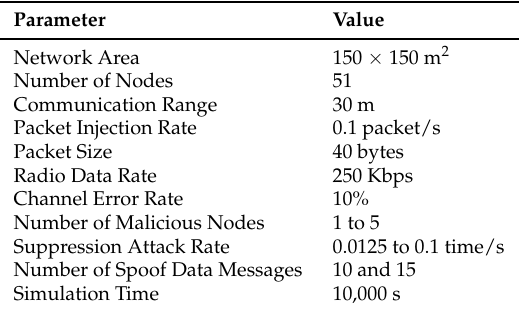
Table 1. Simulation